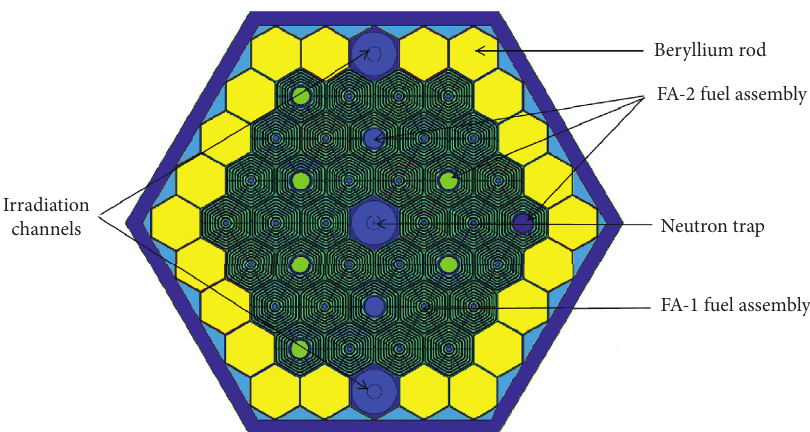
Figure 4: Configuration of the MPRR core with the power output of 10MW.